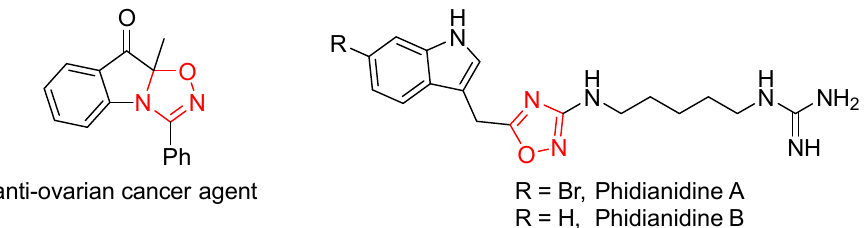
Figure 1. Some biologically active compounds featuring a 1,2,4-oxadiazole motif.